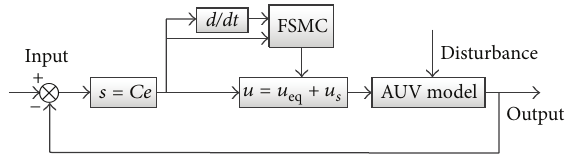
Figure 3: Diagram of fuzzy sliding mode control